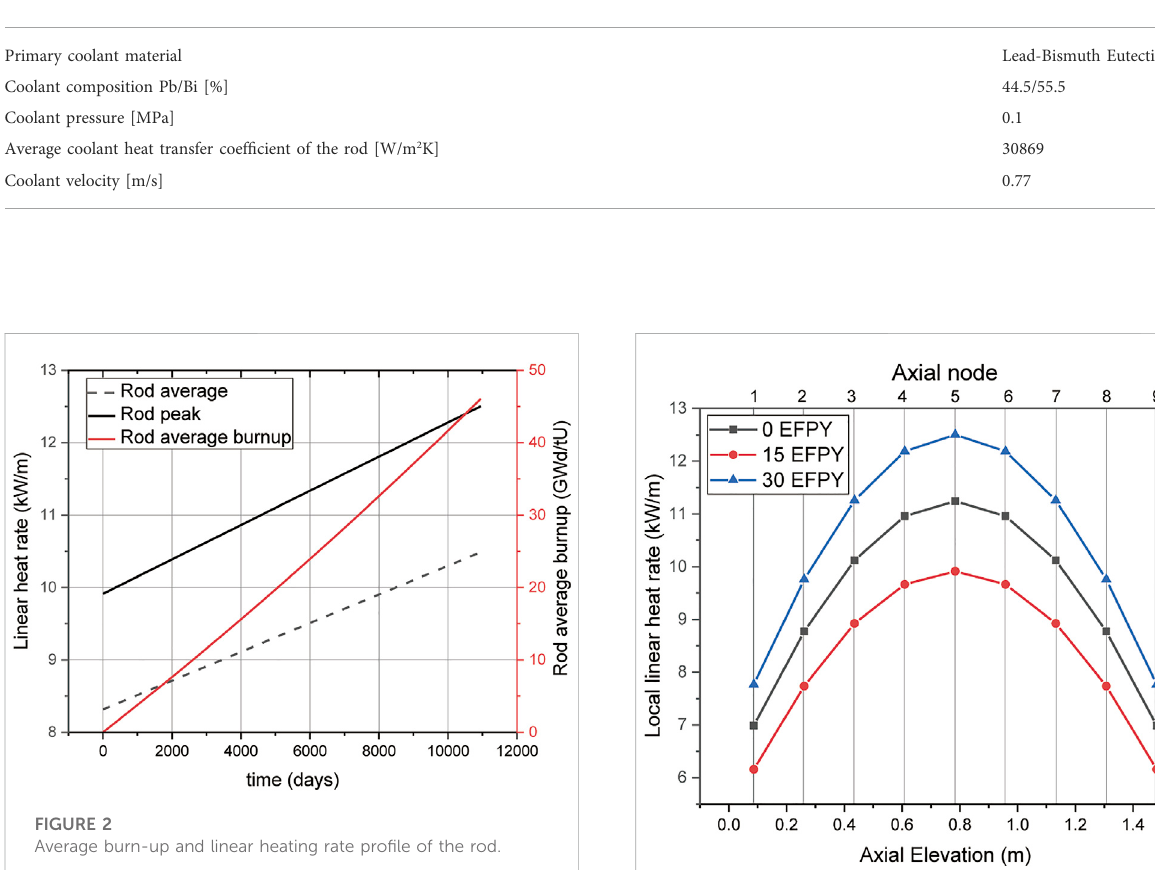
FIGURE 3 Axial peaking for fuel